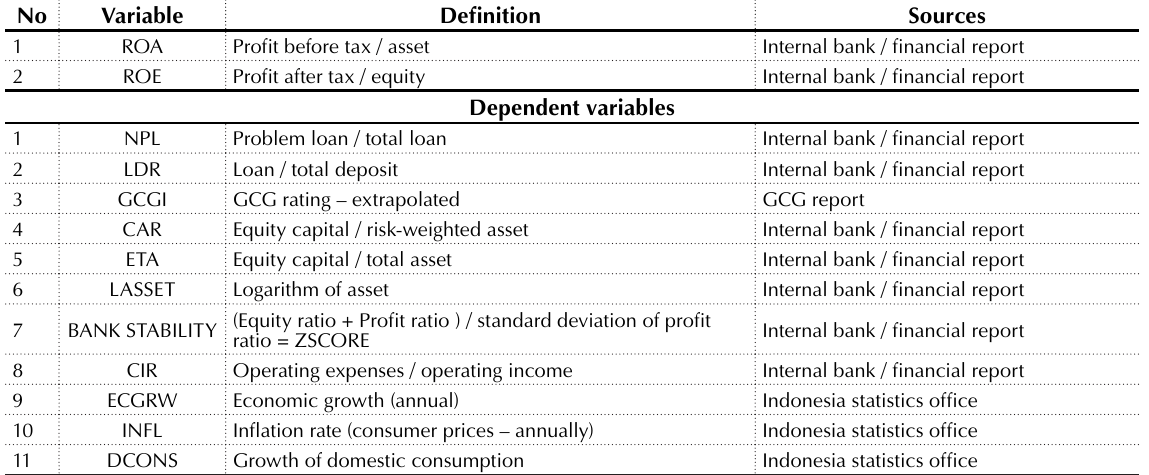
Table 1. Variables, definition and sources of